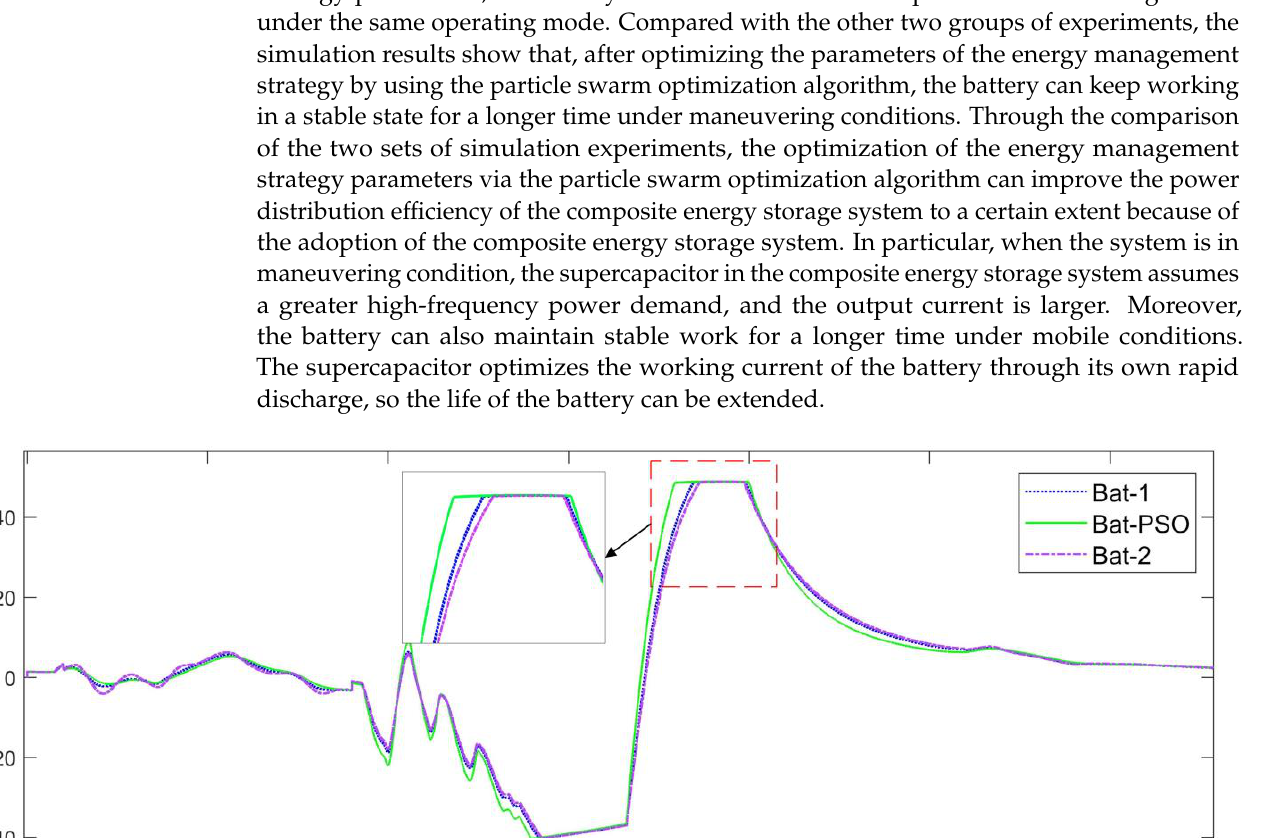
Figure 11. Battery output current under different energy management policy parameters.